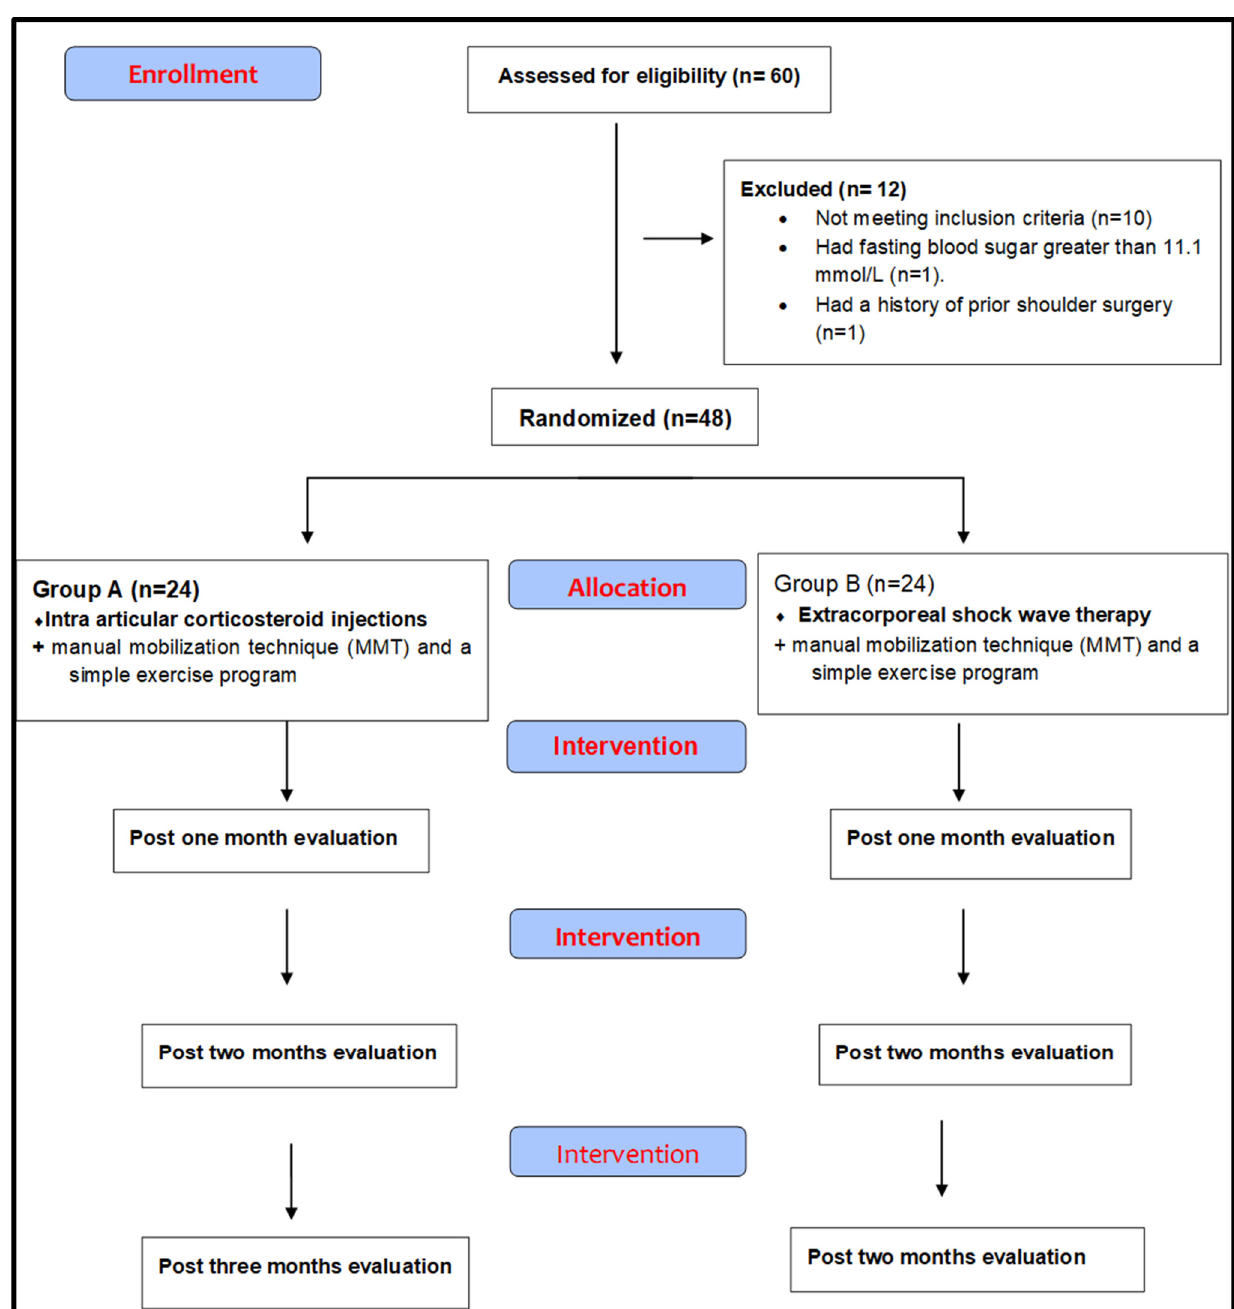
Figure 1. Flow chart of the